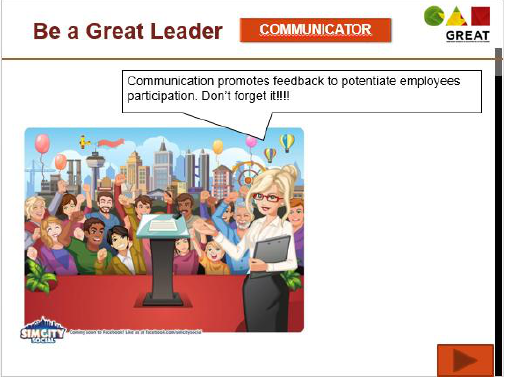
Figure 5. Leader - Communicator